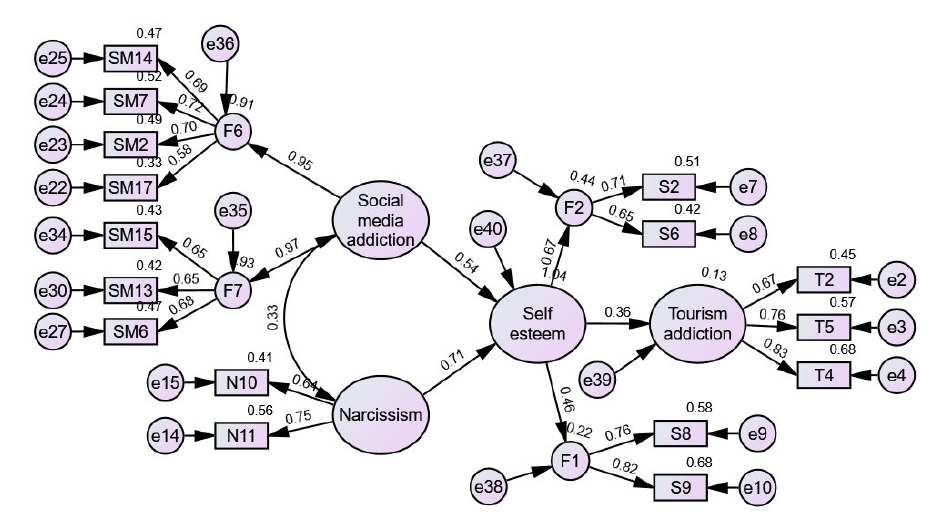
Fig. 2. Structural Model of the First Model Testing